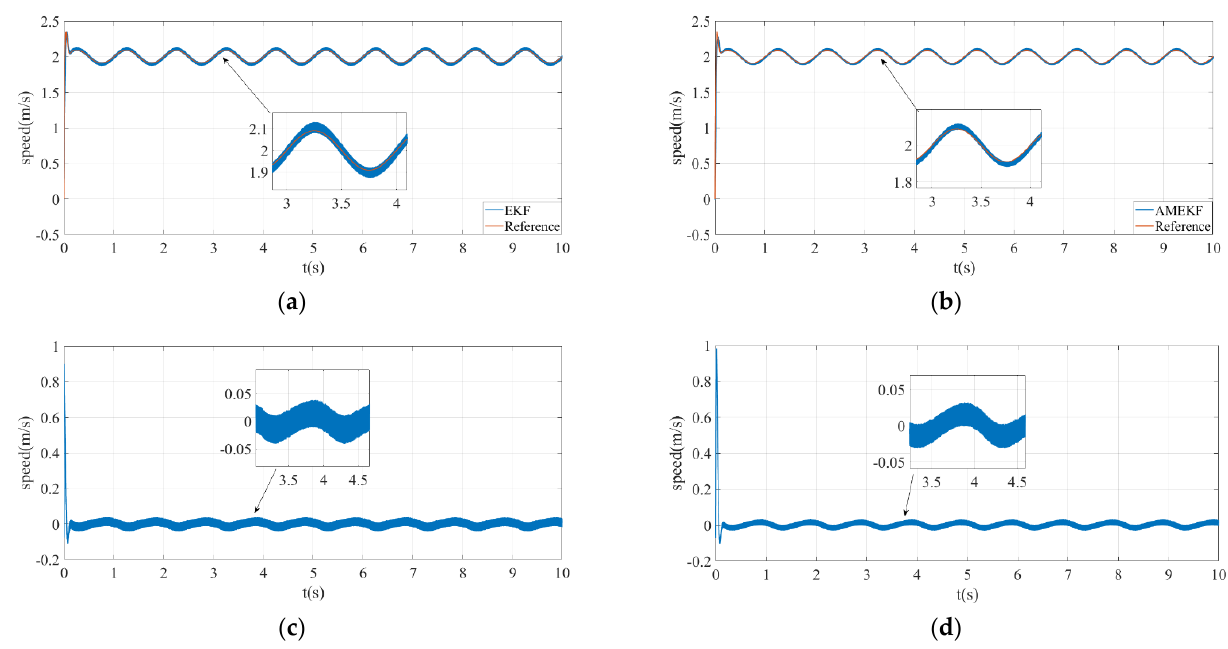
Table 2. Velocity fluctuation error.